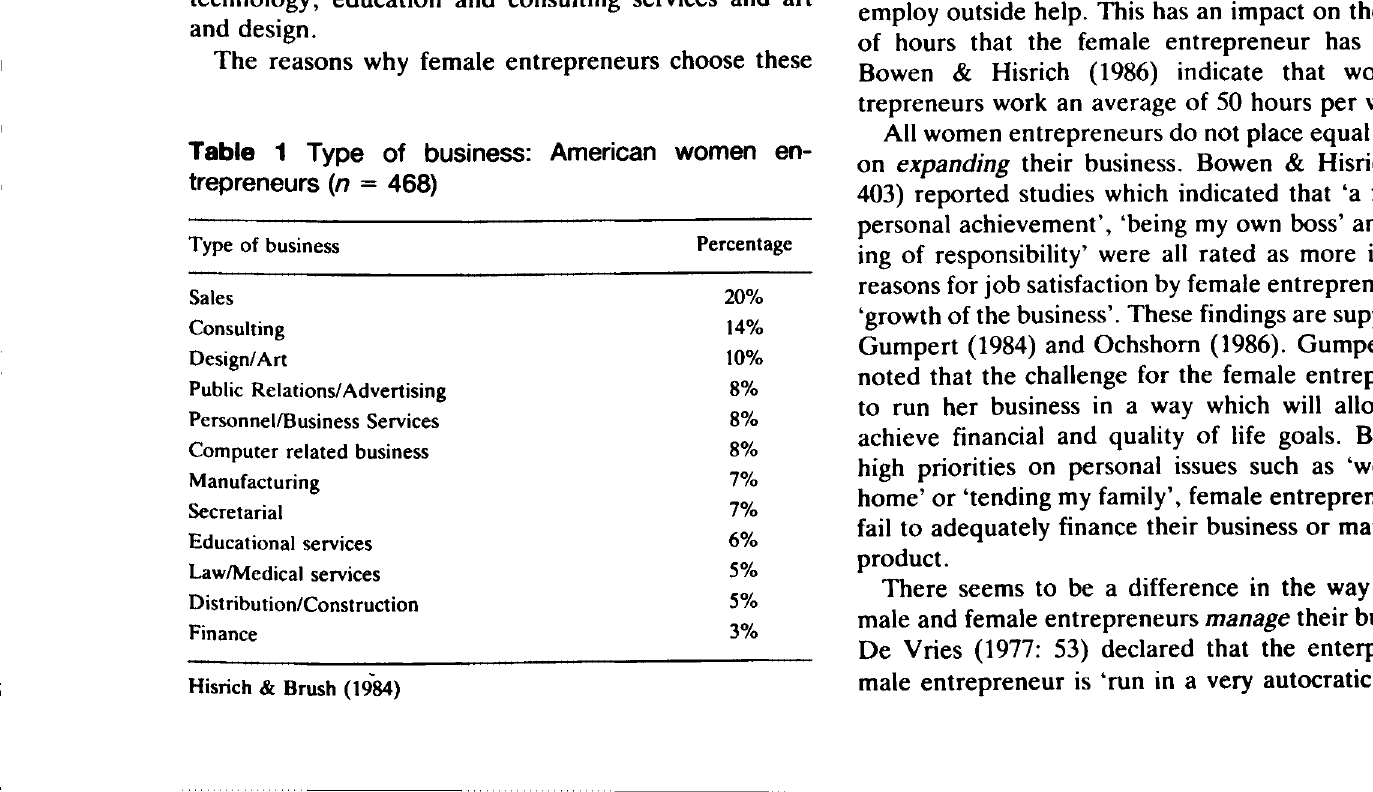
Table 1 Type of business: American women en trepreneurs (n =